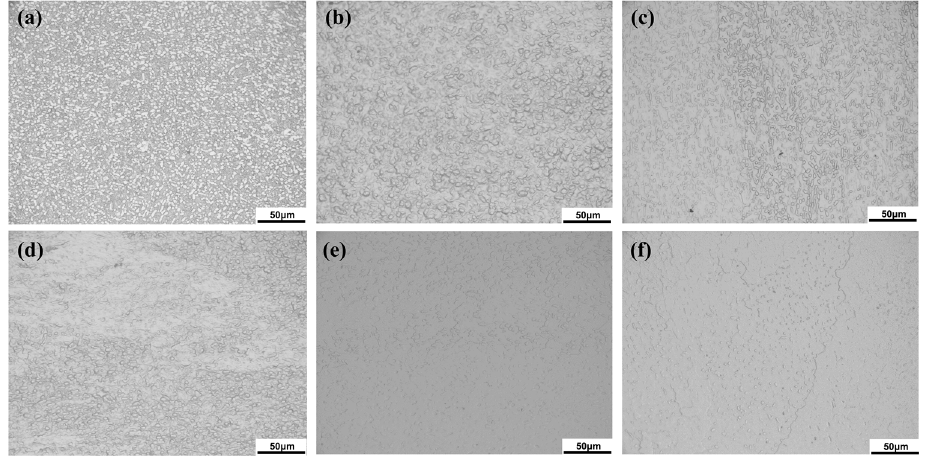
Figure 2. The metallographic cross-sections of TB6 alloy at different conditions: ( a ) the as-received material; ( b ) 740 °C/0.0001 s − 1 ; ( c ) 740 °C/0.01 s − 1 ; ( d ) 740 °C/1 s − 1 ; ( e ) 760 °C/0.0001 s − 1 ; ( f ) 780 °C/0.00001 s − 1 .